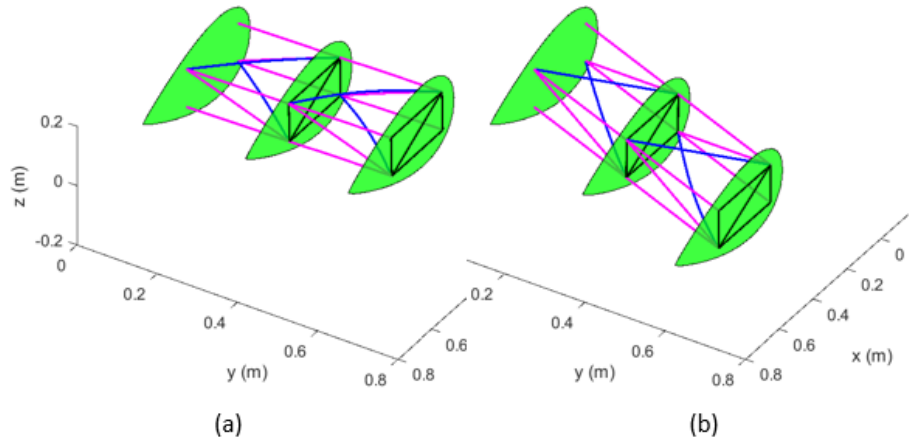
Figure 9. First mode shape for the system in the ( a ) un–morphed configuration, ( b ) morphed configuration (simulation